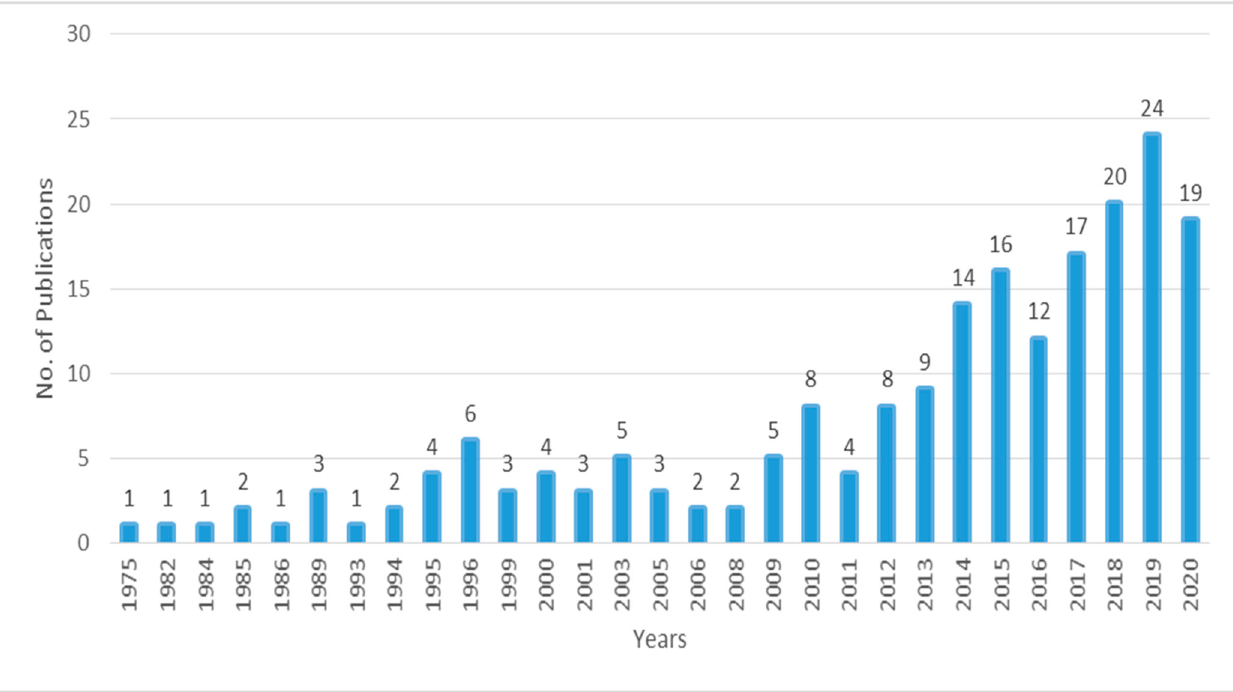
Figure 2. The annual publications trend .